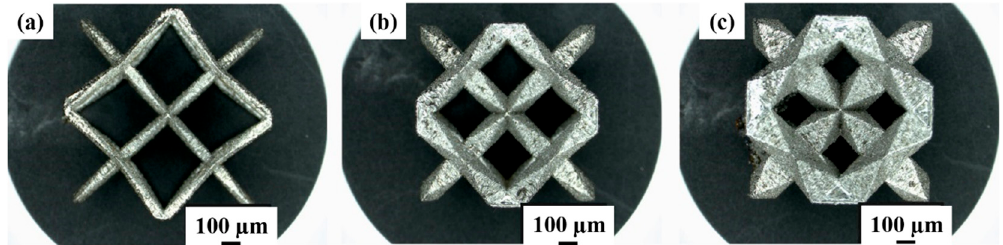
Figure 6. 316L SLM-produced single-unit cells of the rhombi-dodecahedron with different relative densities: ( a ) 4%; ( b ) 12%, and ( c ) 24% respectively.